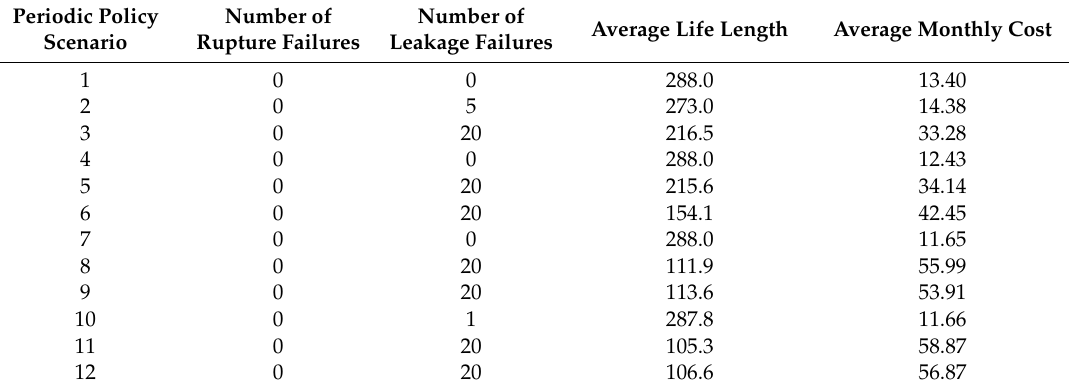
Table 8. Performance summary for the 12 periodic maintenance scenarios in 20 evaluation episodes.